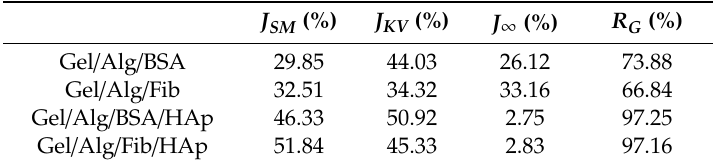
Table 5. Percentage contribution of the Burger elements to the total recovery of the